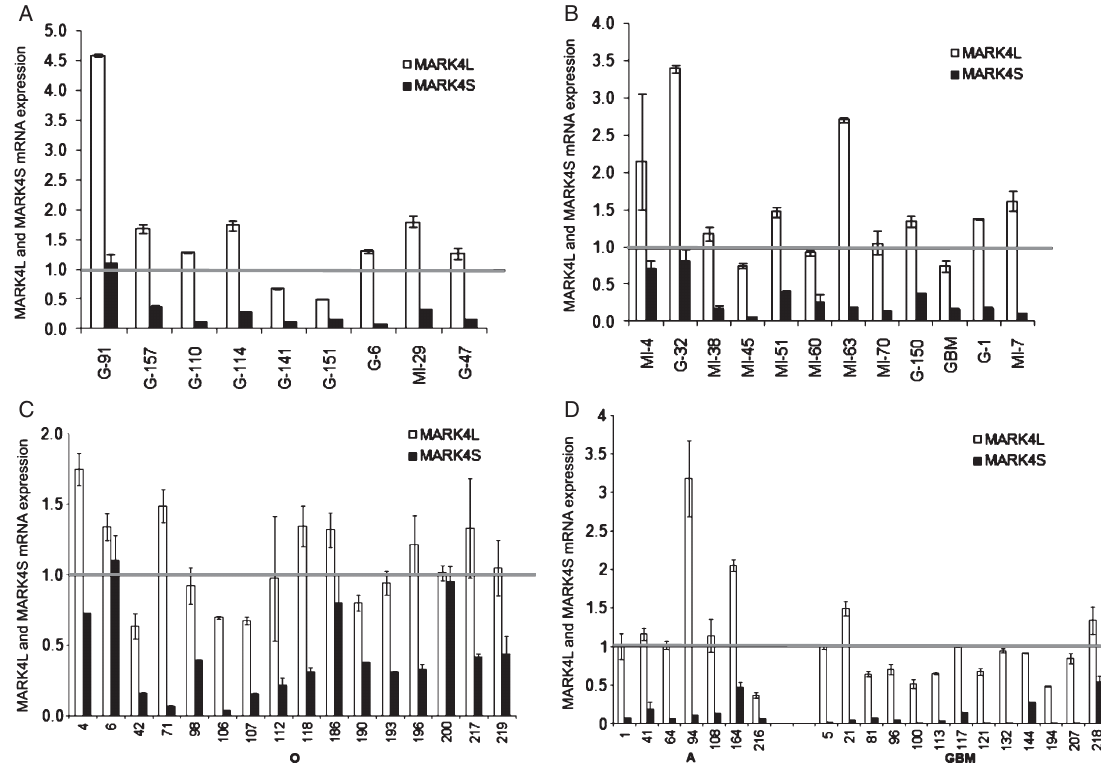
Fig. 1. MARK4L and MARK4S mRNA expression levels. MARK4L (white bar) and MARK4S (black bar) mRNA expression levels in (A) non GBM and (B) GBM cell lines compared with NHNPCs (set as 1 and represented as a horizontal grey line) and in (C) O and (D) A and GBM tissues compared with HNB (set as 1 and represented as a horizontal grey line). Expression data from glioma cell lines were normalized to GAPDH for both MARK4 isoforms, and relative mRNA levels were determined using the (cid:1)(cid:1) Ct method. Expression data from glioma tissues were normalized to GAPDH and (cid:2) -actin and analysed by the (cid:1) Ct method. Data are expressed as mean ± standard